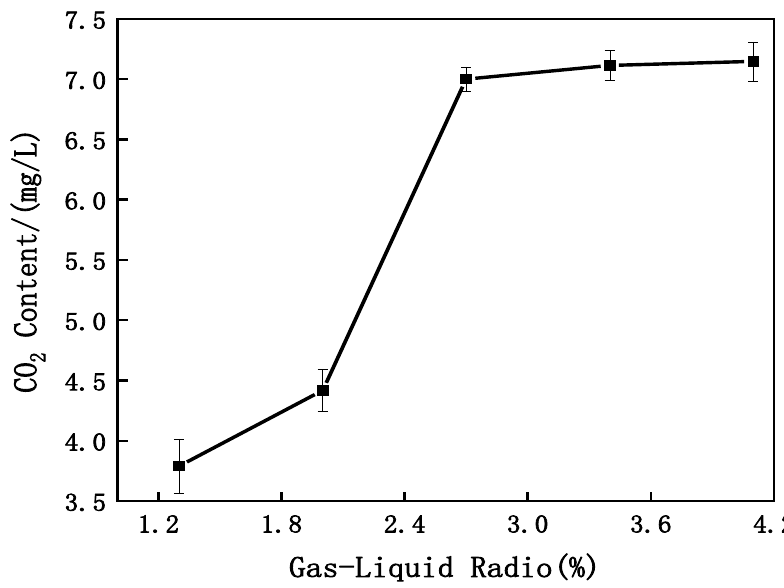
Figure 2. Line chart of the CO 2 content variation at different gas–liquid ratios.